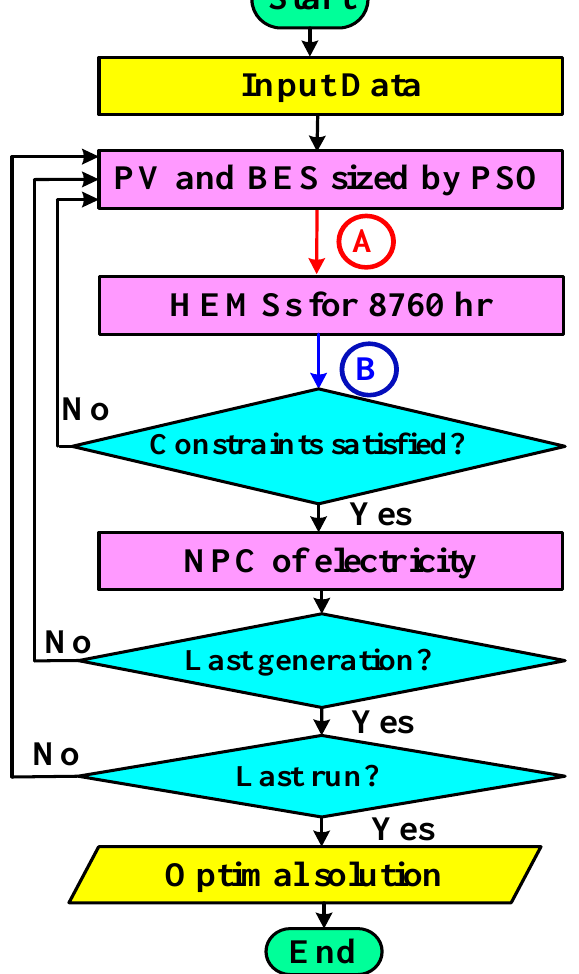
Figure 4. Optimization flowchart for sizing of PV and BESS.